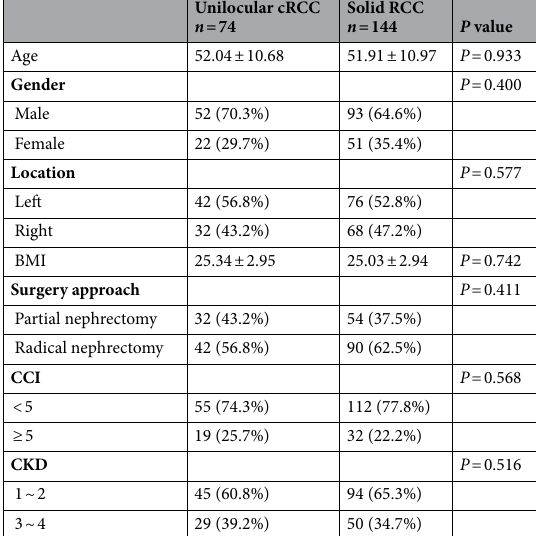
Table 1. Demographic data of unilocular cystic and solid